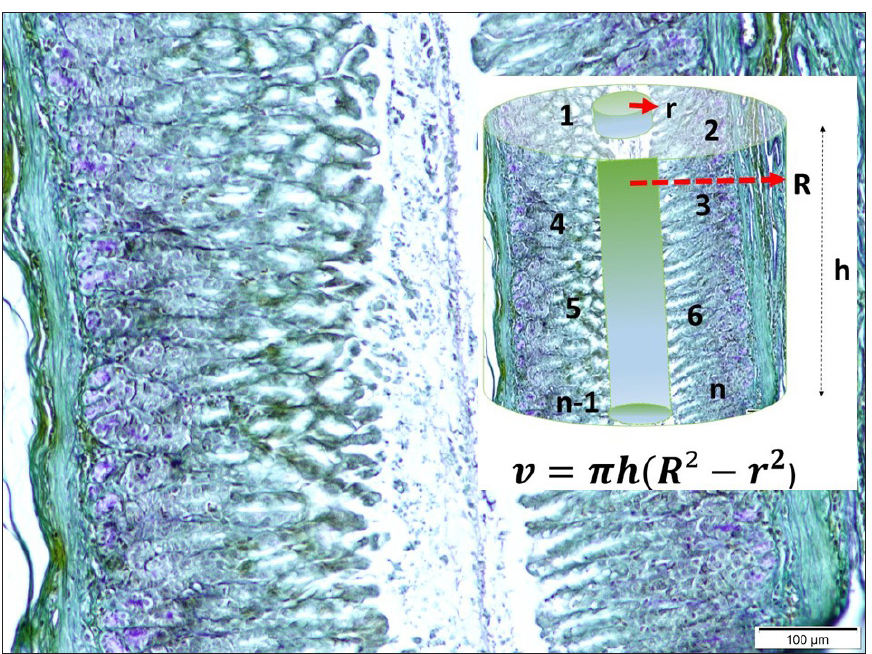
Figure 5. Histological view of the normal intestinal villi (NV) (LM, AF, x10/A) and degenerated villi (Dv/ LM, H&E, x20/A) of a SHAM animal. In the intestines considered to be cylinders, the number of cells per mm2 is determined by dividing the inner wall surface area by the cell surface